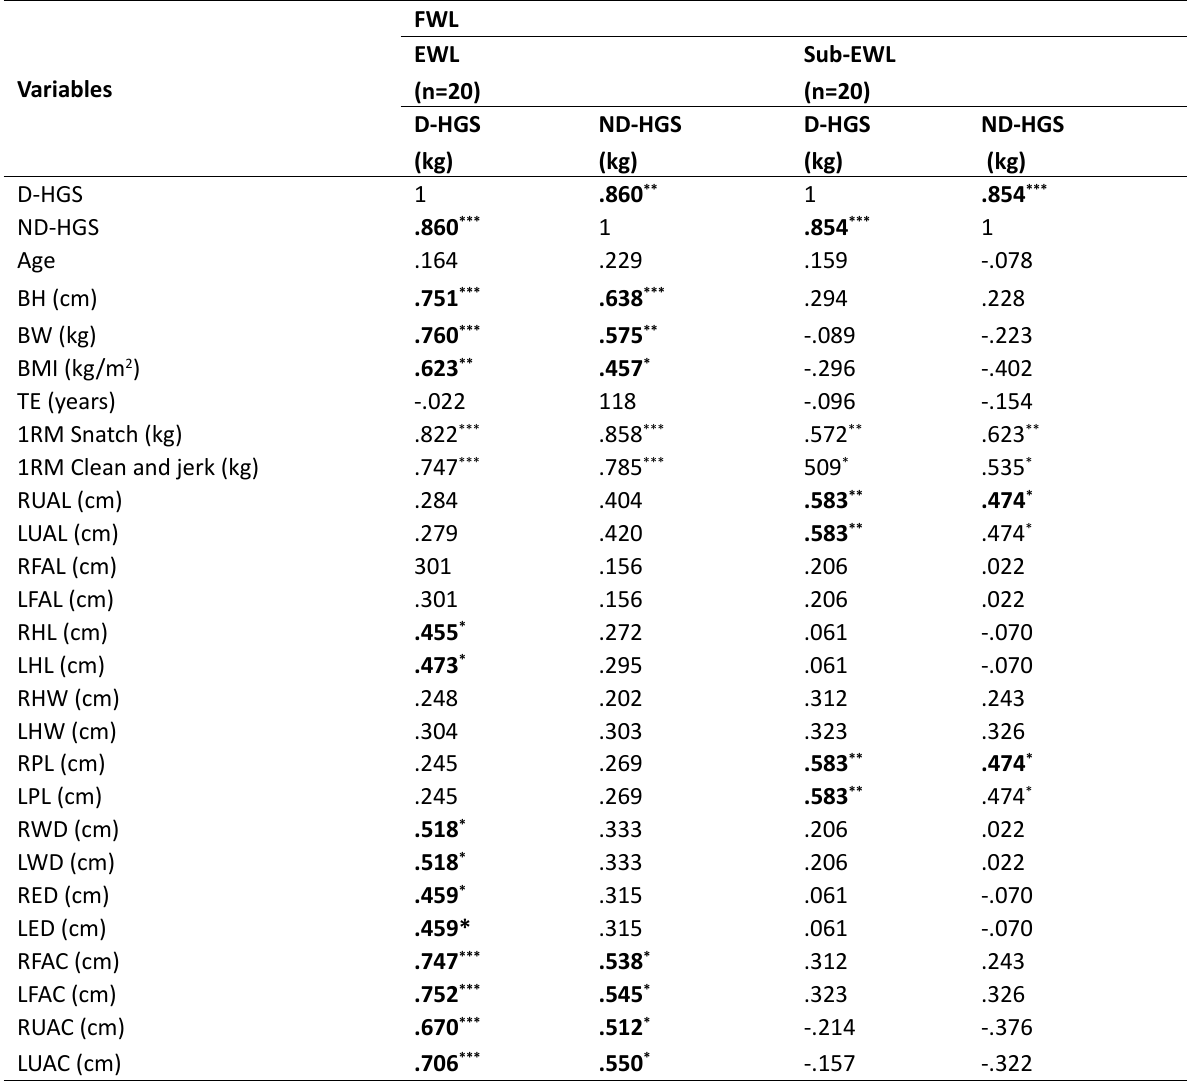
Table 5. The correlations between HGS values of FWL and other variables: anthropometric characteristics, TE, 1RM snatch, 1RM clean-and-jerk